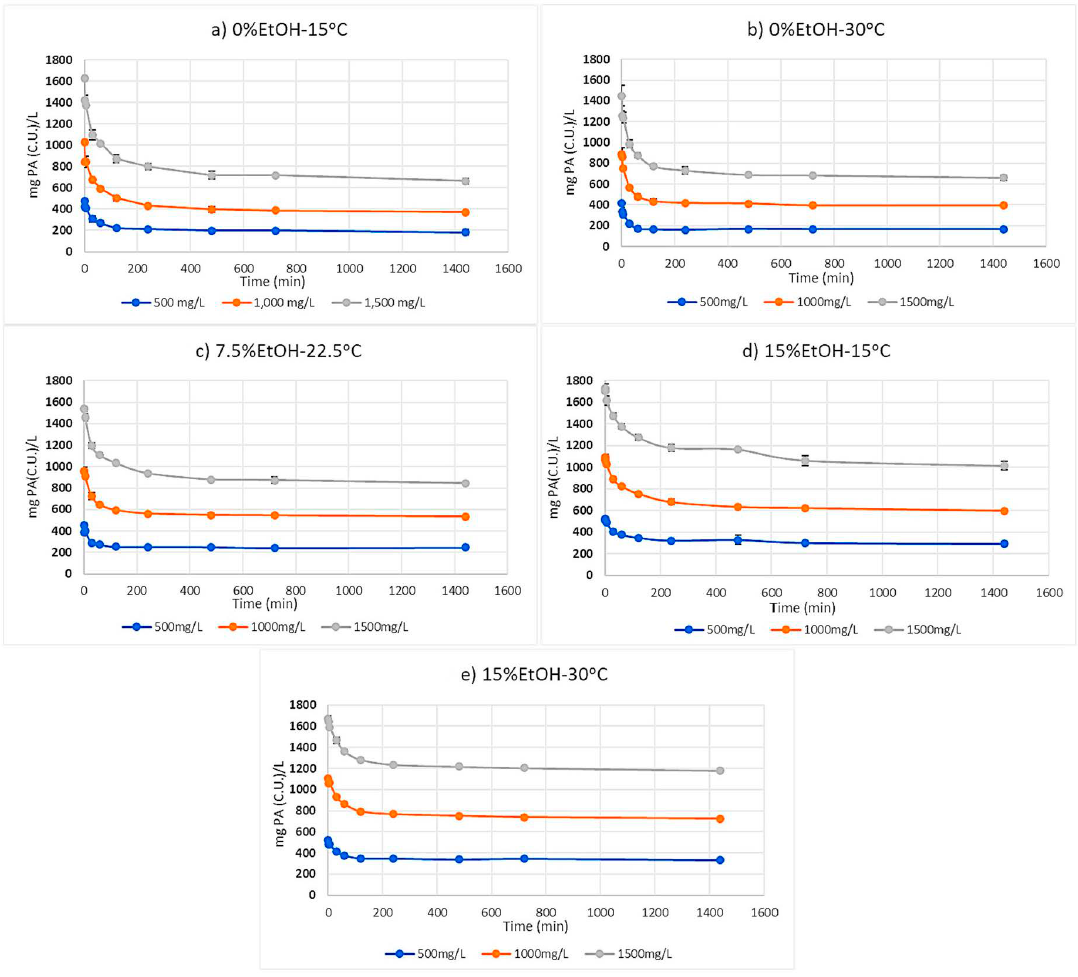
Figure 1. Progress curves of average proanthocyanidin (PA) concentration in solution after exposure to cell wall material (CWM). Standard deviation bars are displayed but often too small to be seen. ( a ) ethanol MW, 15 ◦ C incubation; ( b ) 0% ethanol MW, 30 ◦ C incubation; ( c ) 7.5% ethanol MW, 22.5 ◦ 0% ethanol MW, 15°C incubation; ( b ) 0% ethanol MW, 30 °C incubation; ( c ) 7.5% ethanol MW, 22.5 °C incubation; ( d ) 15% ethanol MW, 15 °C incubation; ( e ) 15% ethanol MW, 30 °C incubation ( n = 3 for each point on progress curves; p < 0.05).